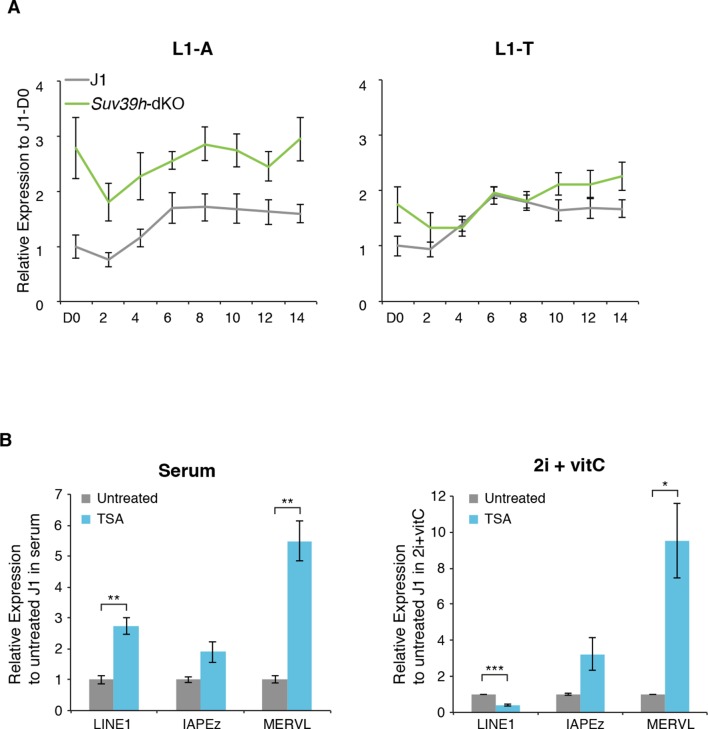
Regulation of transposons by HDACs(A) Expression levels in Suv39h-dKO for L1-A and L1-T families measured by Nanostring nCounter. Data are expressed as fold changes to WT D0 and represent mean ± SEM between three (Suv39h-KO) and eight (J1) biological replicates. (B) Expression levels in WT ES cells treated with the HDACs inhibitor Trichostatin A (TSA) for 24 hr measured by RT-qPCR. Values were normalized to Gapdh and Rplp0. Data are expressed as the fold change to untreated cells and represent mean ± SEM between two (untreated control) and four biological replicates (treated with 25 or 50 ng/mL of TSA, with undistinguishable effect between the two concentrations). *p<0.05, **p<0.01 and ***p<0.001 (unequal variances t-test).